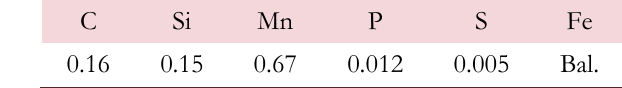
Figure 3: Test specimen.